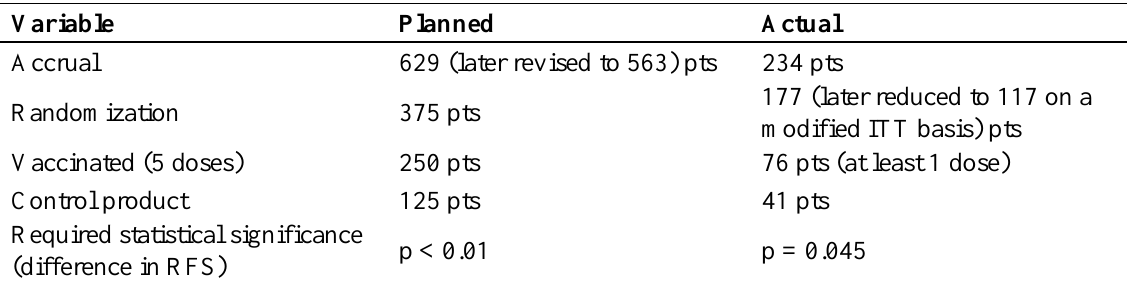
Table 2. Comparison between approval requirements and actual achievements of the phase-III randomized trial on BiovaxId TM . Legend: pts: patients; ITT: intent to treat; RFS: relapse-free